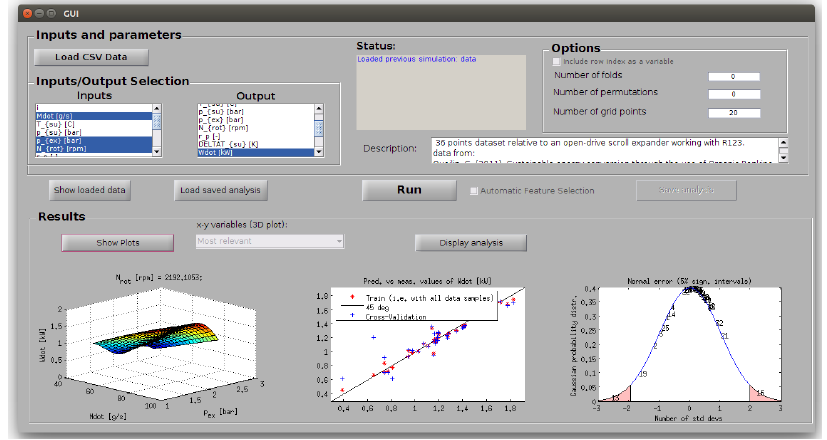
Figure 12. Main window of the GPExp graphical user interface